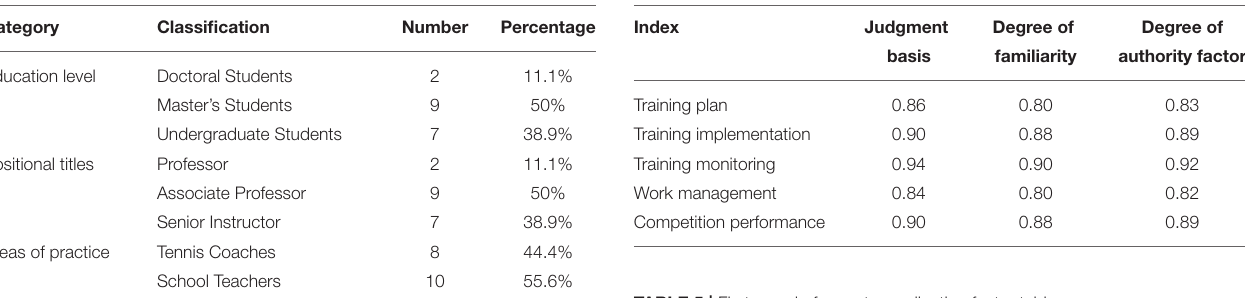
TABLE 5 | First round of expert coordination factor table.